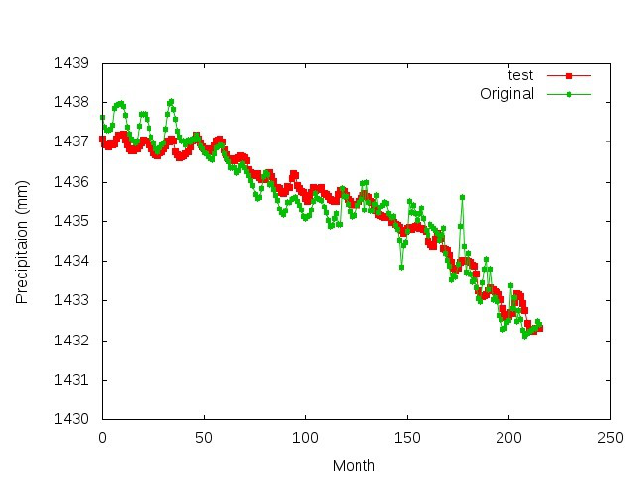
Fig. 11: Training under 500 hidden units and x function